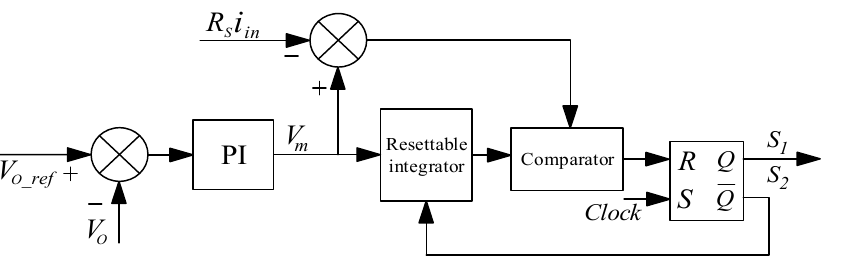
Figure 3. Bridgeless PFC control